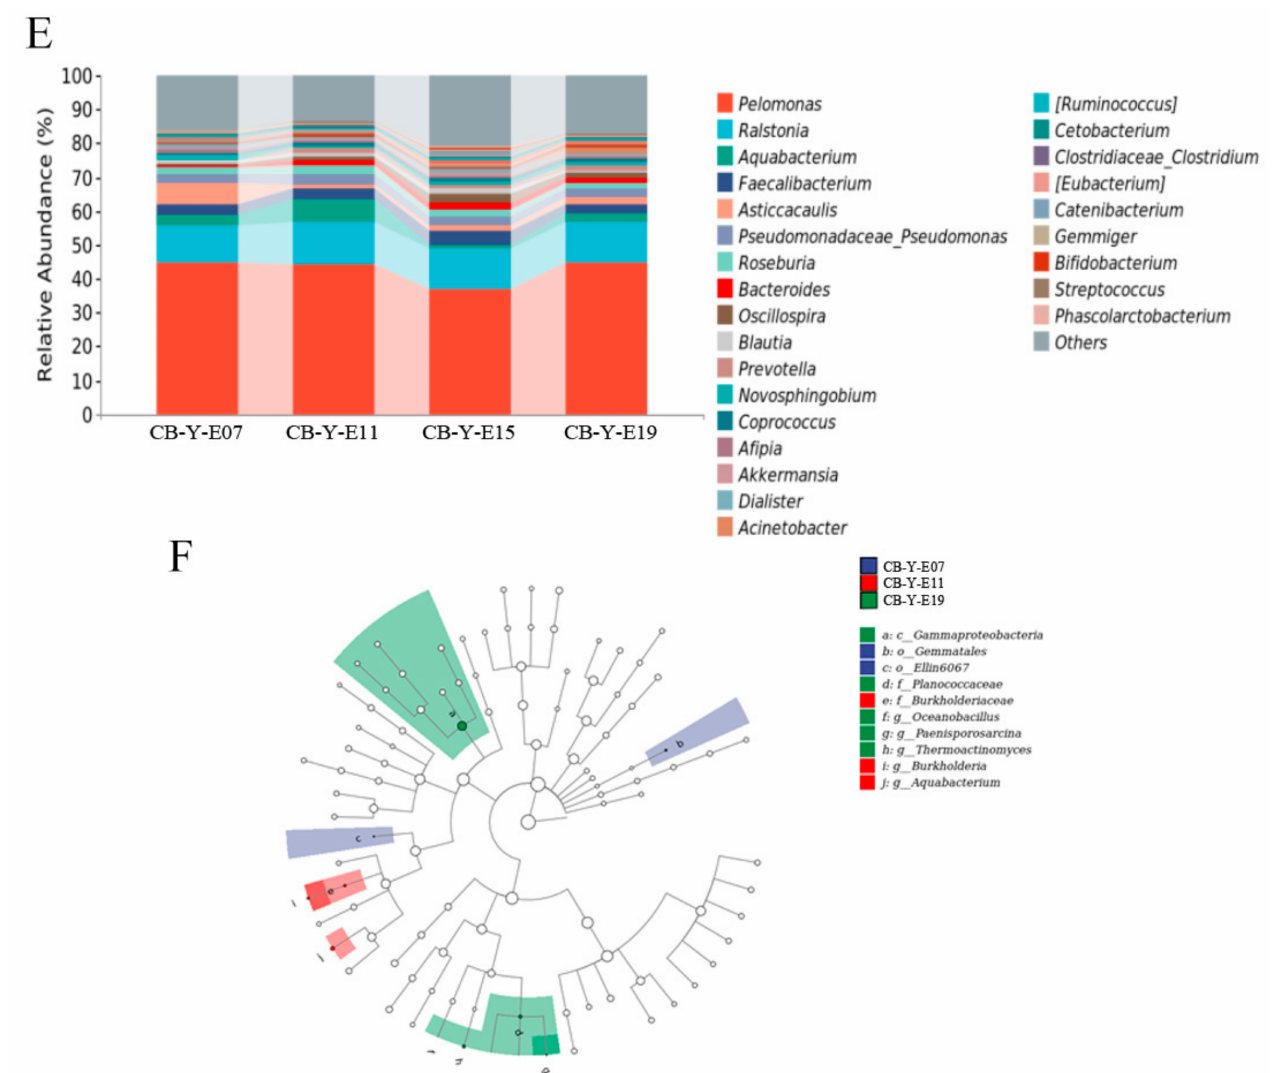
Figure 2. Embryonic yolk microbial difference at different developmental stages. CB in the picture represents commercial broilers and Y represents yolk. ( A ) PCA: Each point represents a sample, and points of different colors indicate different groups. ( B ) Each panel corresponds to an alpha diversity index, which is identified in the gray area at the top. In each panel, the abscissa is the group label, and the ordinate is the value of the corresponding alpha diversity index. ( C ) The relative abundance of yolk microbiota in the chicken embryo at different days. ( D ) The Venn diagram shows the core microbes shared at different stages of development. ( E ) The relative abundance of yolk microbiota in the chicken embryo at different days (at the genus level). ( F ) Taxonomic cladogram generated from LEfSe showing significant difference in the microbiota profile of 4 stages of